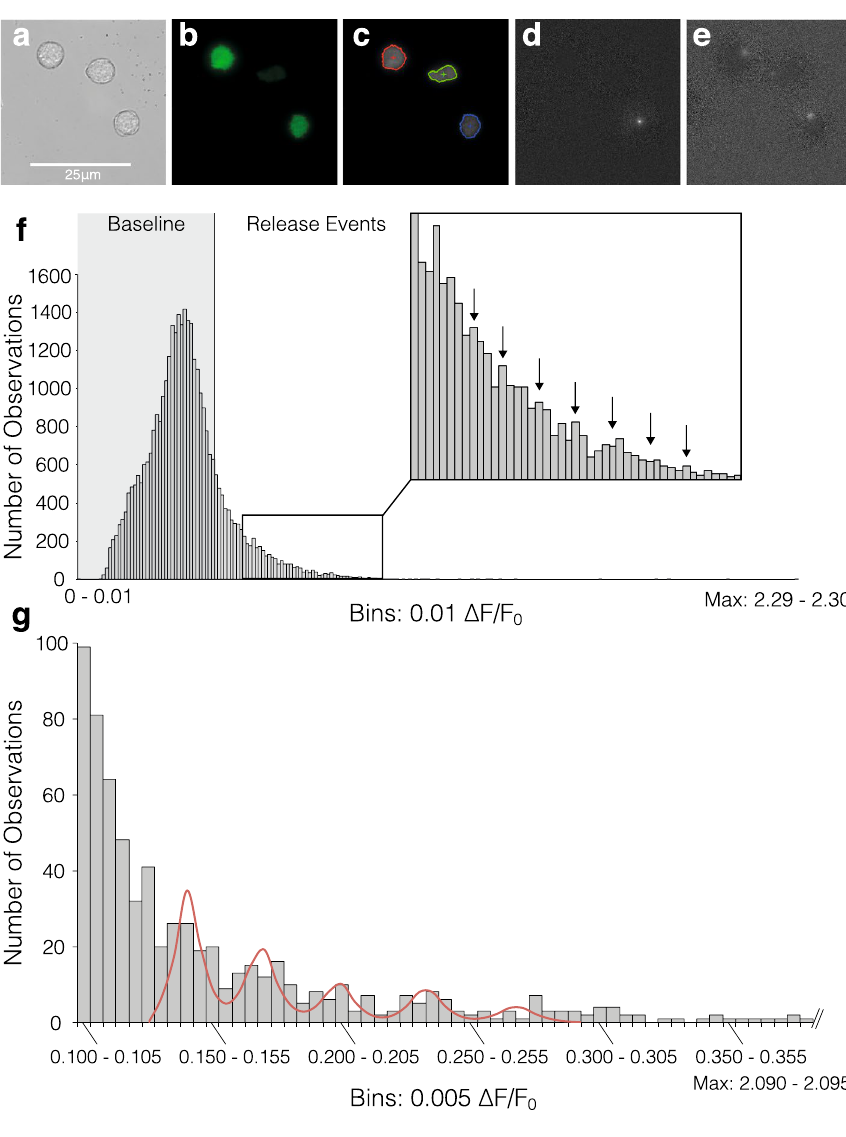
Figure 4. Quantal analysis of elementary events. ( a – e ) Illustration of spark analysis, including examples of elementary release events in response to 16.5 mM glucose detected by normalisation, frame by frame and background subtraction in 3 individual β-cells: ( a ) Original brightfield, ( b ) TIRF, ( c ) Boundaries used in detection analysis, ( d – e ) Individual events isolated by analysis. Note that images of glucose-induced events were chosen for illustration of the analysis mechanism; quantal analysis was carried out exclusively on NAADP-AM stimulated cells. ( f ) Frequency histogram of maximum intensity change after NAADP-AM Stimulation (n = 20), the vertical line at 0.44 ΔF/F 0 denotes 2 standard deviations above baseline mean. ( g ) Frequency histogram of mean event amplitudes across areas of interest (n = 51) within a single cell cluster stimulated with NAADP-AM in the presence of 5 mM EGTA. The five peaks of the putative modal distribution in the data were selected as means for individual Gaussian distributions; and 3–4 bins to their left and right used to calculate the respective distribution’s standard deviation. The resultant means and standard deviations were used to fit a quintuple Poly- Gaussian function (Sum of five Gaussian functions with Means, SDs: 0.143, 0.007; 0.171, 0.008; 0.201, 0.0089; 0.235, 0.0092; 0.270, 0.0103, respectively) to the data. Histogram was cropped for better resolution-values below event cutoff (2 standard deviations above baseline mean: 0.1 ΔF/F 0 ) are not included and actual maximum intensity bin is